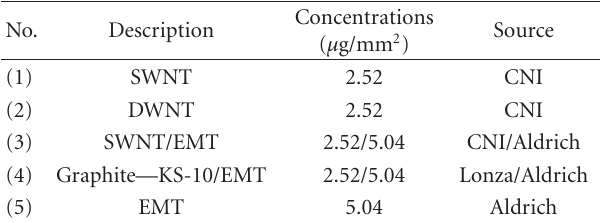
Table 1: Summary of lubricant